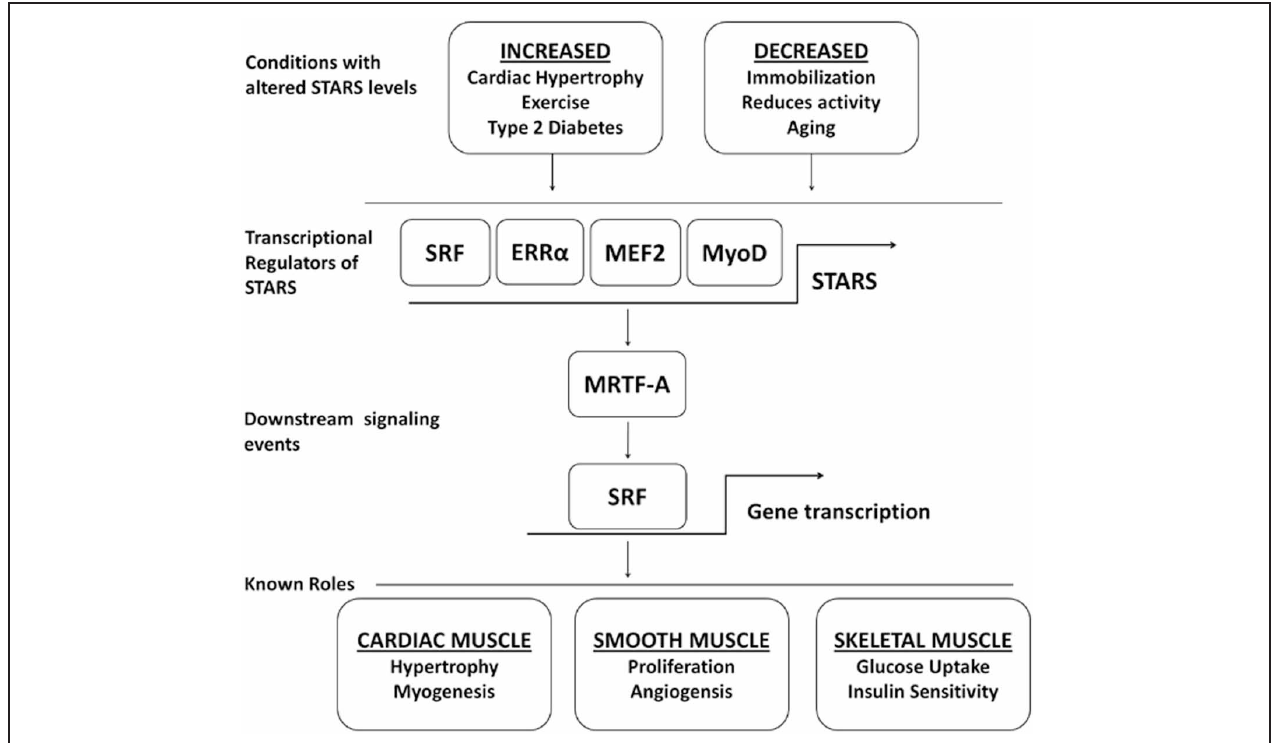
FIGURE 1 | A schematic outline highlighting the physiological and pathophysiological conditions that show a regulation of STARS, the transcription factors known to upregulate STARS, the downstream signaling events controlled by STARS, and the biological roles of STARS.